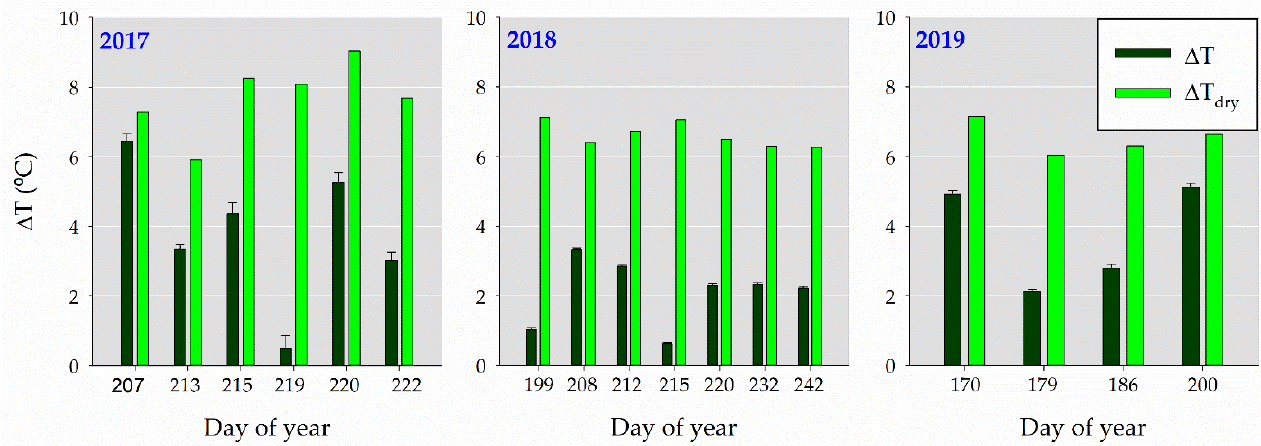
Figure 8. Mean ∆ T values observed during the water stress period in the deficit irrigation treatments (WS). In 2019, the first two dates correspond to the flowering stress treatment (WS1) and the last two dates to the grain-filling stress treatment (WS2). For each measurement date, the ∆ T dry values calculated with Equation (3) are also plotted. Each bar indicates the mean ± s.e. of 18 (2017, 2018) and 12 (2019) maize breeding plots.